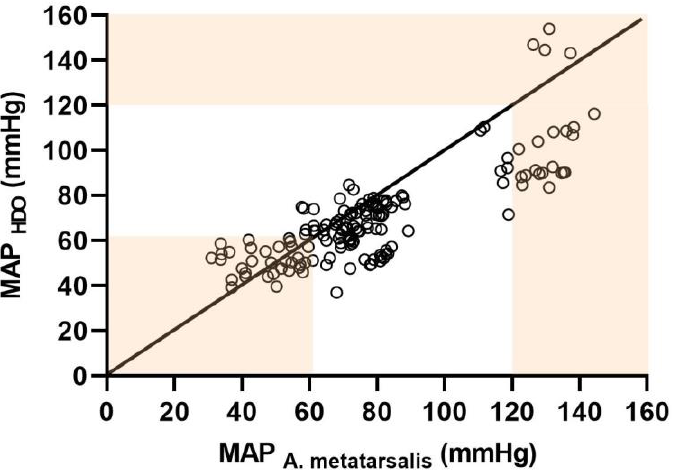
Figure 2. XY plot for mean arterial pressure (MAP) obtained by invasive (IBP) technique at the metatarsal artery (MA) (x-axis) and non-invasive (NIBP) technique by high-definition oscillometry (HDO) (y-axis) at the contralateral MA in 11 isoflurane anaesthetised and dorsally recumbent horses at different blood pressure ranges (normotension: MAP 61–119 mmHg; hypotension: MAP ≤ 60 mmHg; hypertension: MAP ≥ 120 mmHg). A total of 152 paired measurements are depicted. The black straight line represents the line of identity of both measurement techniques. The red-coloured zones represent hypotension and hypertension, respectively.